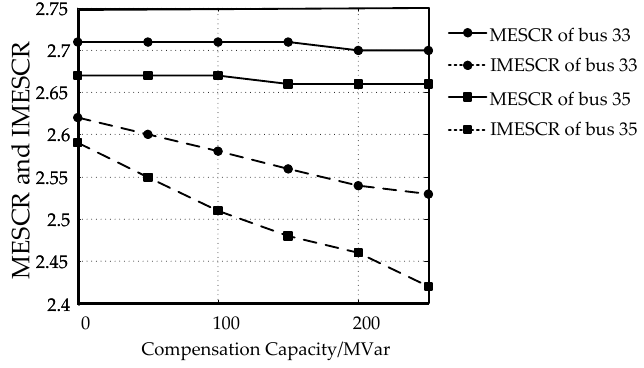
Figure 5. MESCR and IMESCR of two DC inverter buses under different compensation capacities.